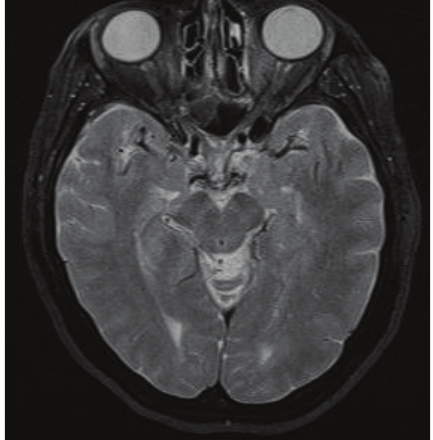
Figure 5: Cranial magnetic resonance imaging one month later (the neuropathy in the left optic nerve was